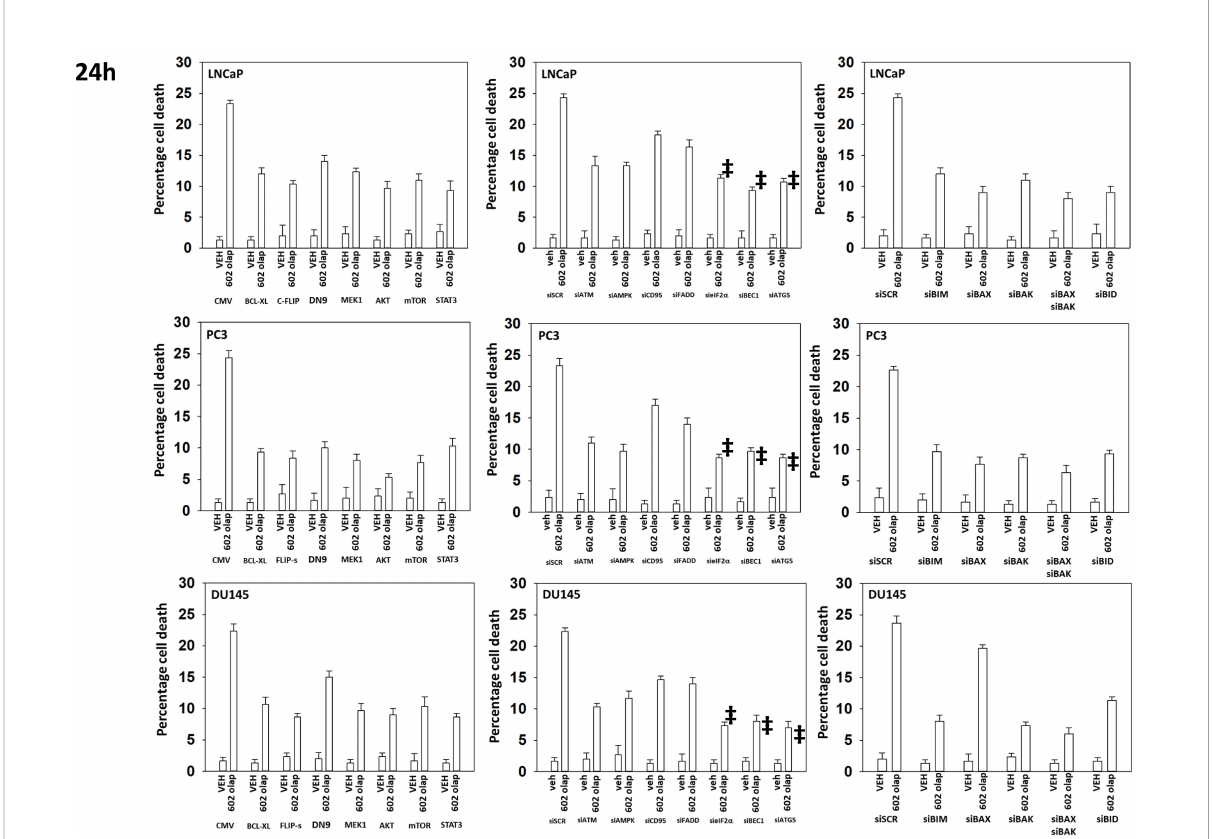
FIGURE 11 Knock down of Beclin1, ATG5 or eIF2 a , or over-expression of FLIP-s signi fi cantly reduces the lethality of [GZ17-6.02 + olaparib]. Prostate cancer cells were transfected with an empty vector plasmid or with plasmids to express BCL-XL, FLIP-s, dominant negative caspase 9, activated MEK1, activated AKT, activated mTOR or activated STAT3. Cells were transfected with a scrambled siRNA or with siRNA molecules to knock down the expression of ATM, AMPK a , CD95, FADD, eIF2 a , Beclin1, ATG5, BIM, BAX, BAK and BID. After 24h, cells were treated with vehicle control or with